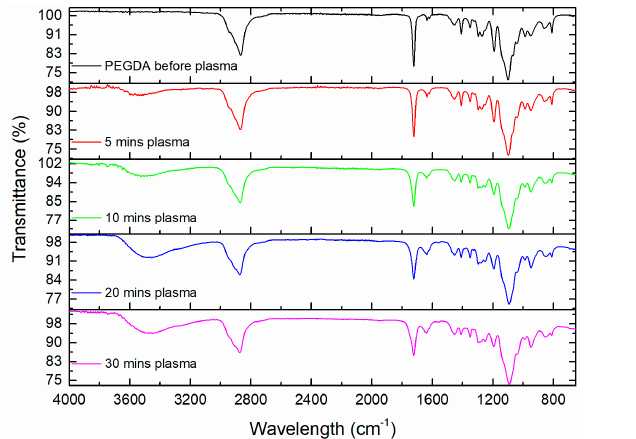
Figure 2. FT ‐ IR spectra of PEGDA before and after several DBD plasma treatment times. ( A ) The full range of the FT ‐ IR spectra taken. ( B ) The x ‐ axis has been truncated to better show the annotated bands of interest.